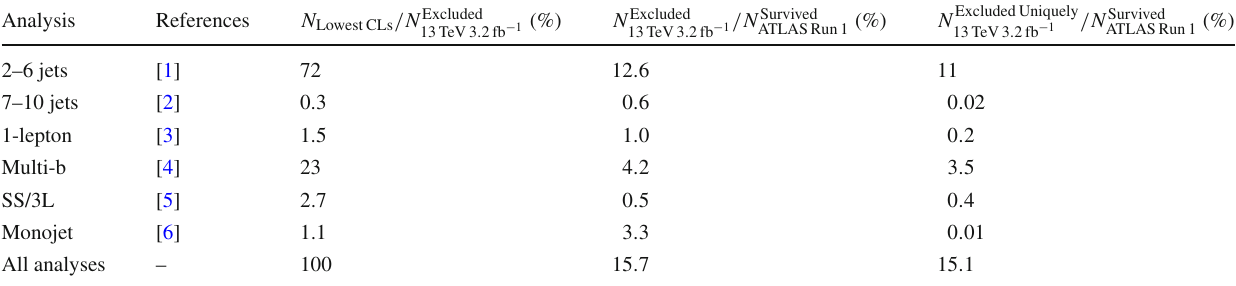
Table 1 List of the ATLAS 13 TeV (3.2 fb − 1 ) analyses used to constrain the 181.8k model points that survived Run 1. The col- umn N LowestCLs / N Excluded denotes the fraction of the 28.5k 13TeV3 . 2fb − 1 excluded models for which the indicated analysis was the most sen- sitive, i.e. had the lowest CLs value N Lowest CLs as discussed in Sect. 2.1; these figures may not sum to 100% due to rounding.